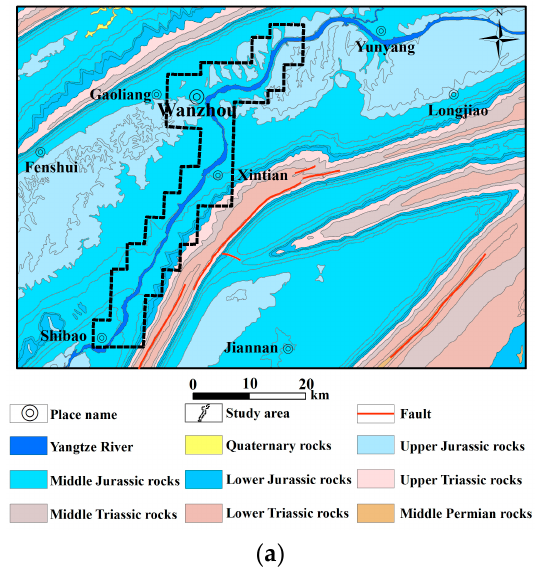
Figure 8 . Cont . Figure 8.